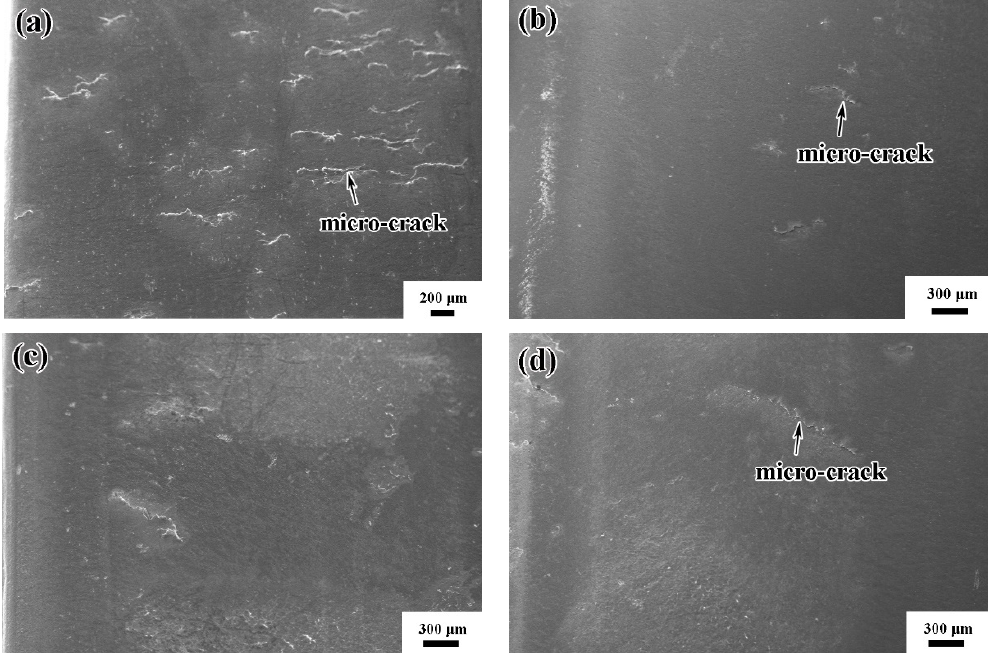
Figure 9. Worn surface of 1380G rail steel under different rolling cycles. ( a ) 1.0 × 10 5 cycles; ( b ) 2.5 × 10 5 cycles; ( c ) 5.0 × 10 5 cycles; ( d ) 7.5 × 10 5 cycles.